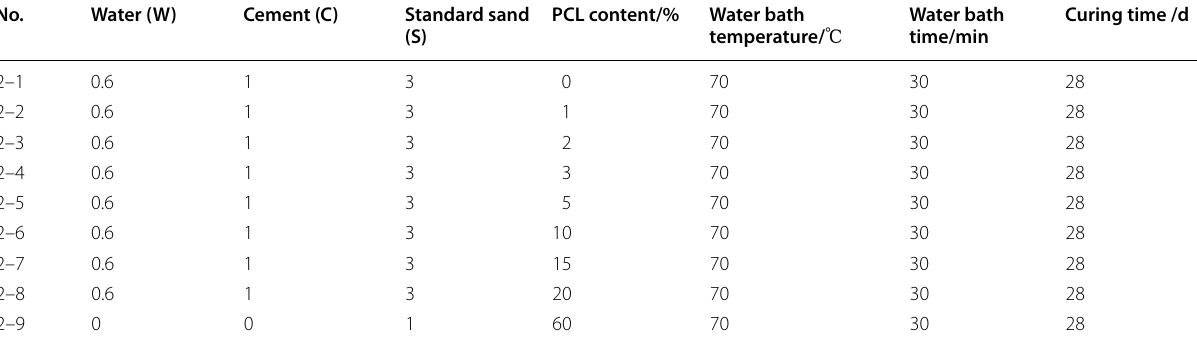
Table 3 PCL‑cement mortar samples mix